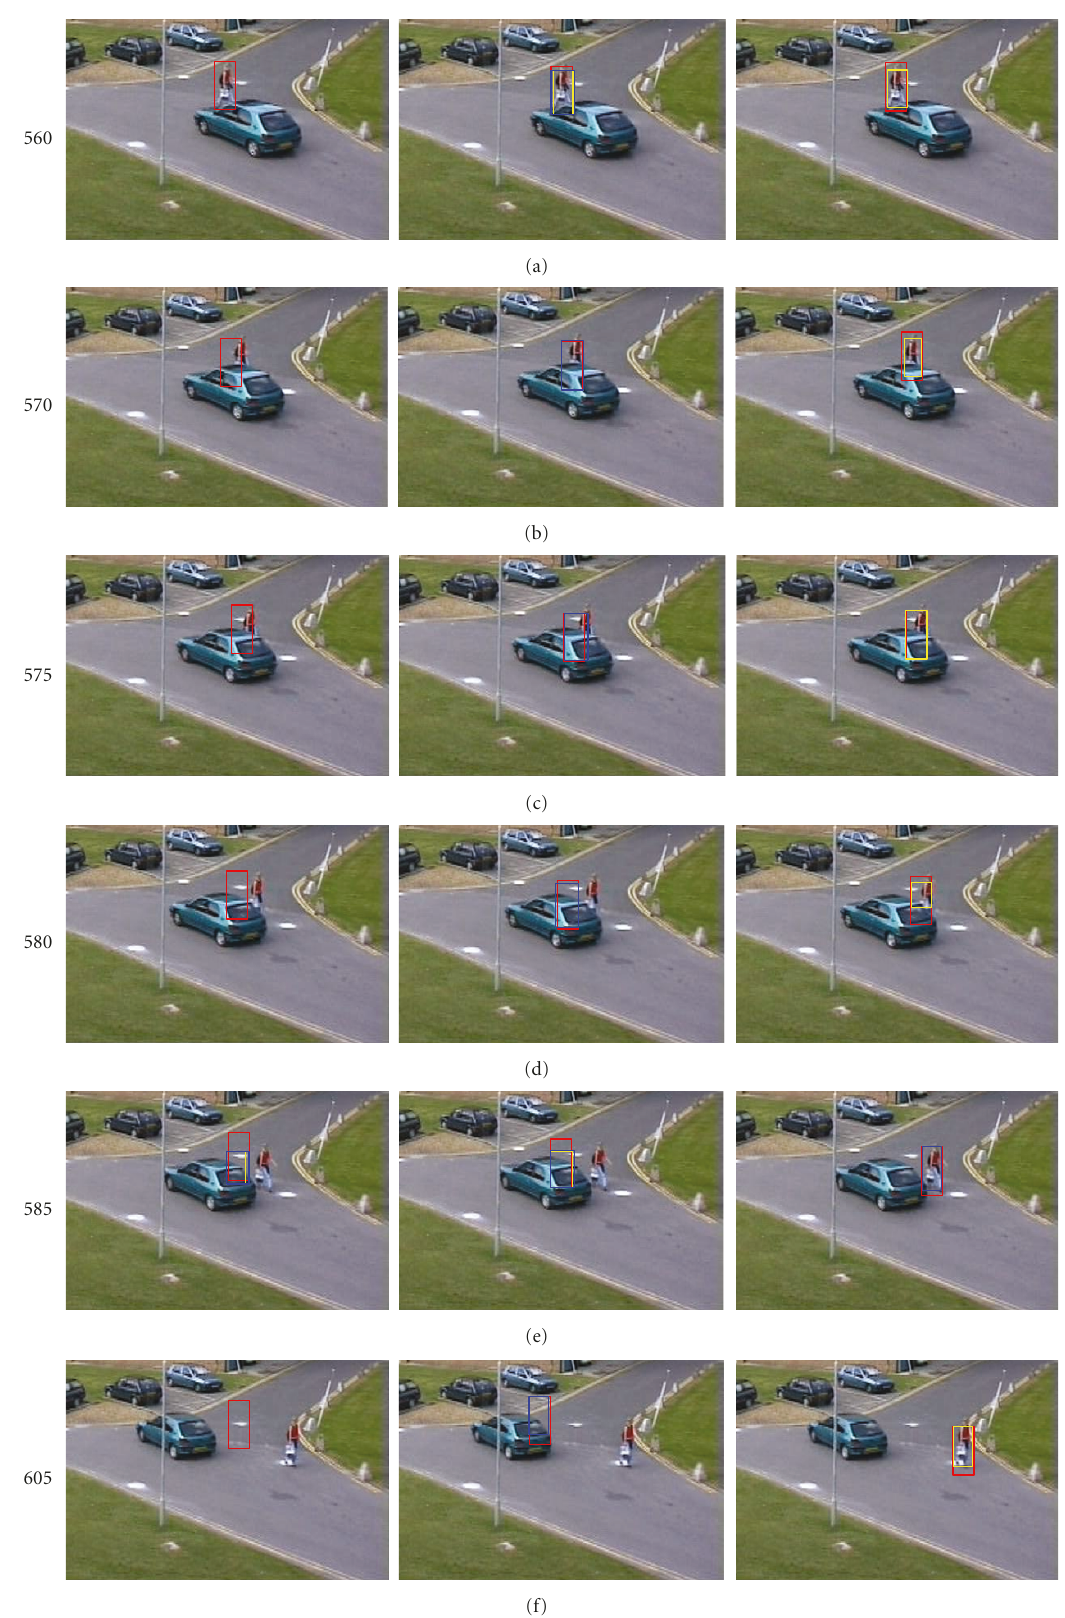
Figure 11: Tracking results in three di ff erent modes. First column: tracking, occlusion detection, and stop learning during occlusion. Second column: tracking using partial learning along with the addition of unassociated corners to the model. Third column: tracking using partial learning, but without the addition of unassociated corners to the